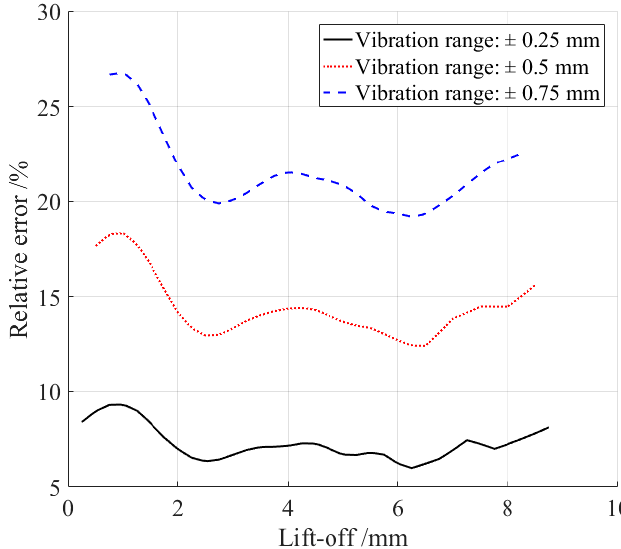
Figure 14. The relative error caused by vibration.